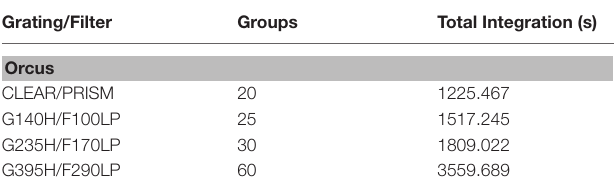
FIGURE 1 | Sensitivity limits (10- σ ) for the NIRSpec integral field unit (IFU), with the various filter/grating combinations. The G140H and G140M gratings are shown for only the F100LP filter combination. This plot was created using the JWST Exposure Time Calculator (ETC) found at jwst.etc.stsci.edu and the following parameters: a point source with a flat continuum set to 10 µ Jy, the NRSIRS2RAPID readout mode, FULL frame subarray, 67 groups/1 integration/1 exposure (totaling 992s of photon collection time), the “IFU Nod Off Scene” strategy, a 0.2” aperture radius, and a high background centered